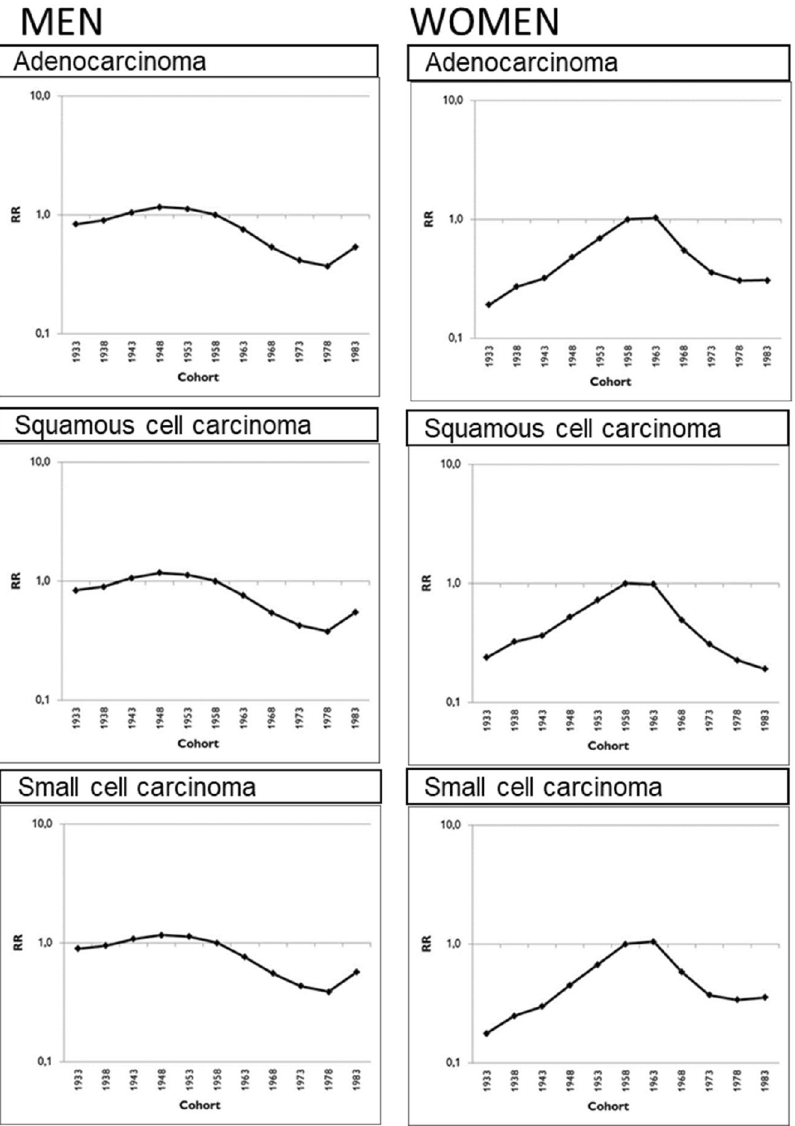
Figure 4. Relative risk of incidence by birth cohort for lung cancer by sex and histology in Catalonia for the 1931 to 1985 birth cohorts. Note: These figures resulted from a cohort model of effect of the birth cohort. Reference cohort: 1958